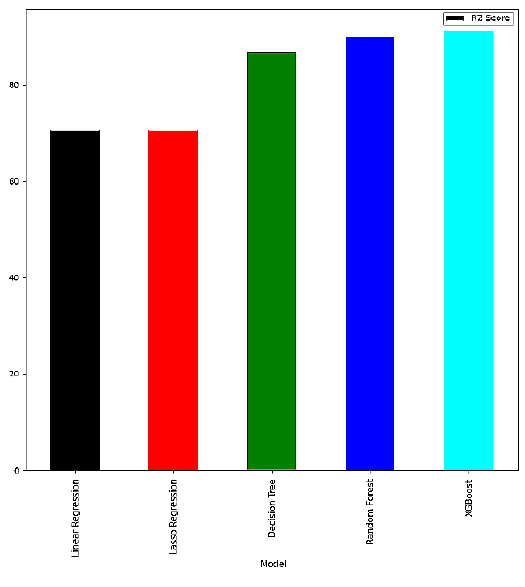
Figure 18. Bar plot comparing R 2 scores of different regressors.